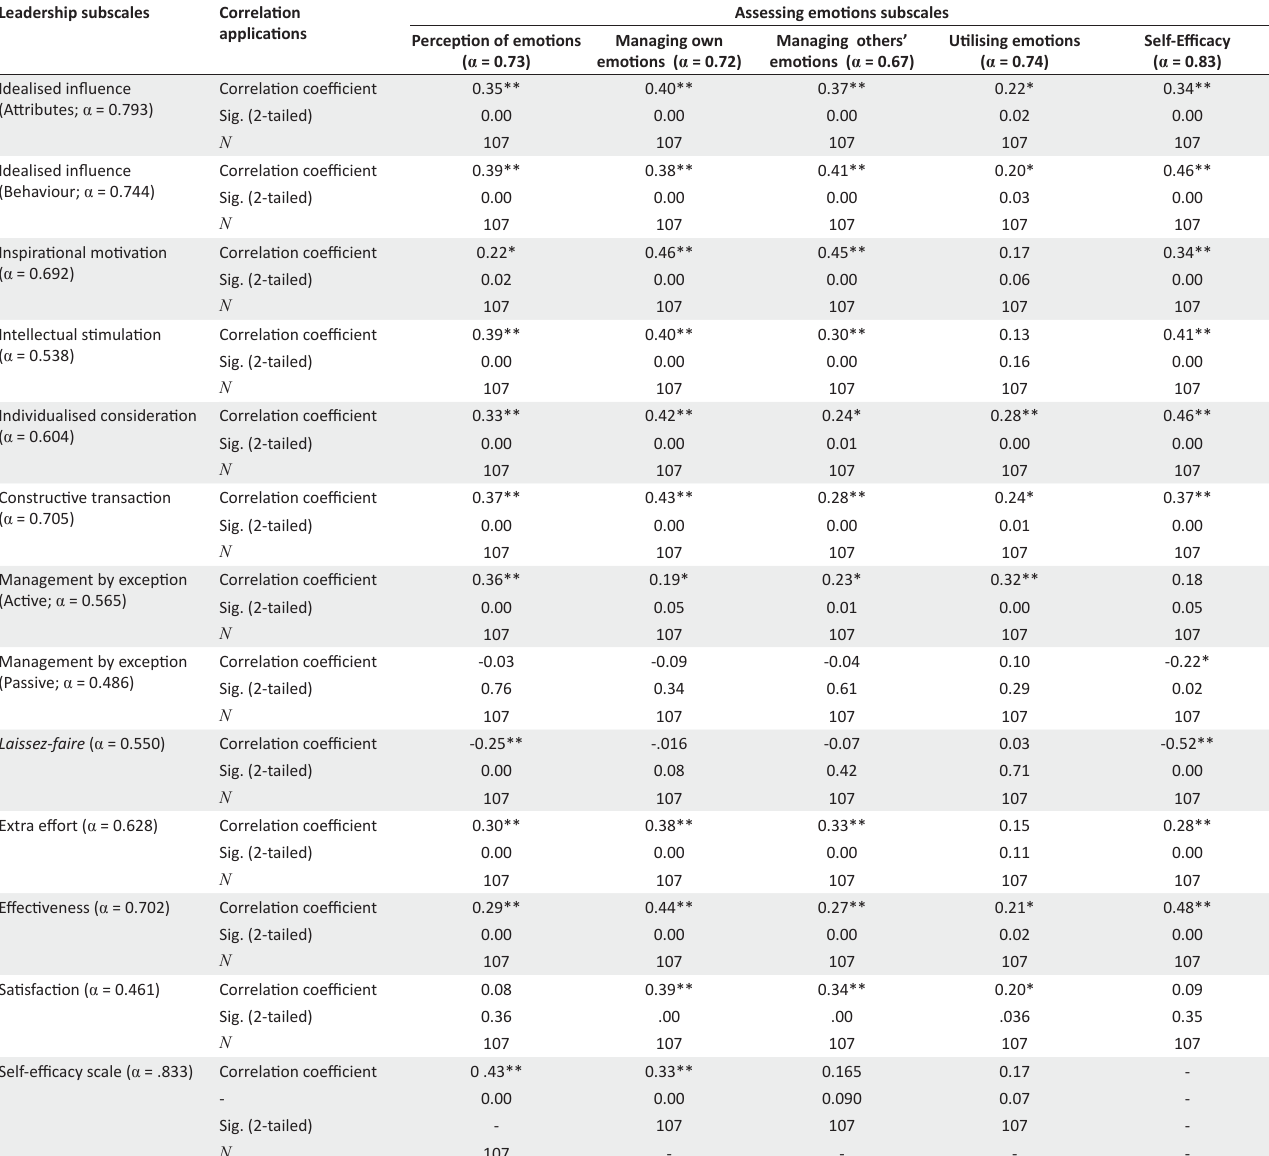
TABLE 8: Correlations between the self-efficacy scale and the subscales of Assessing Emotions Scale and the Multifactor Leadership Questionnaire. Leadership subscales